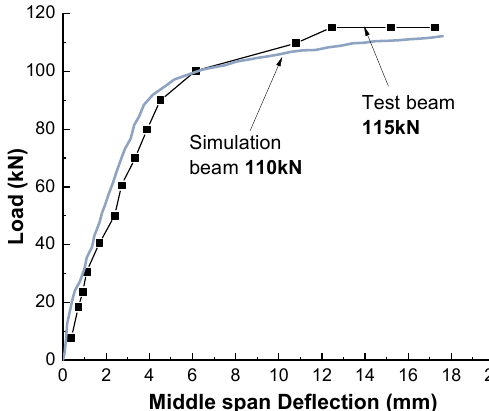
Figure 6. Deflection development curve of RC beam under sustained load.